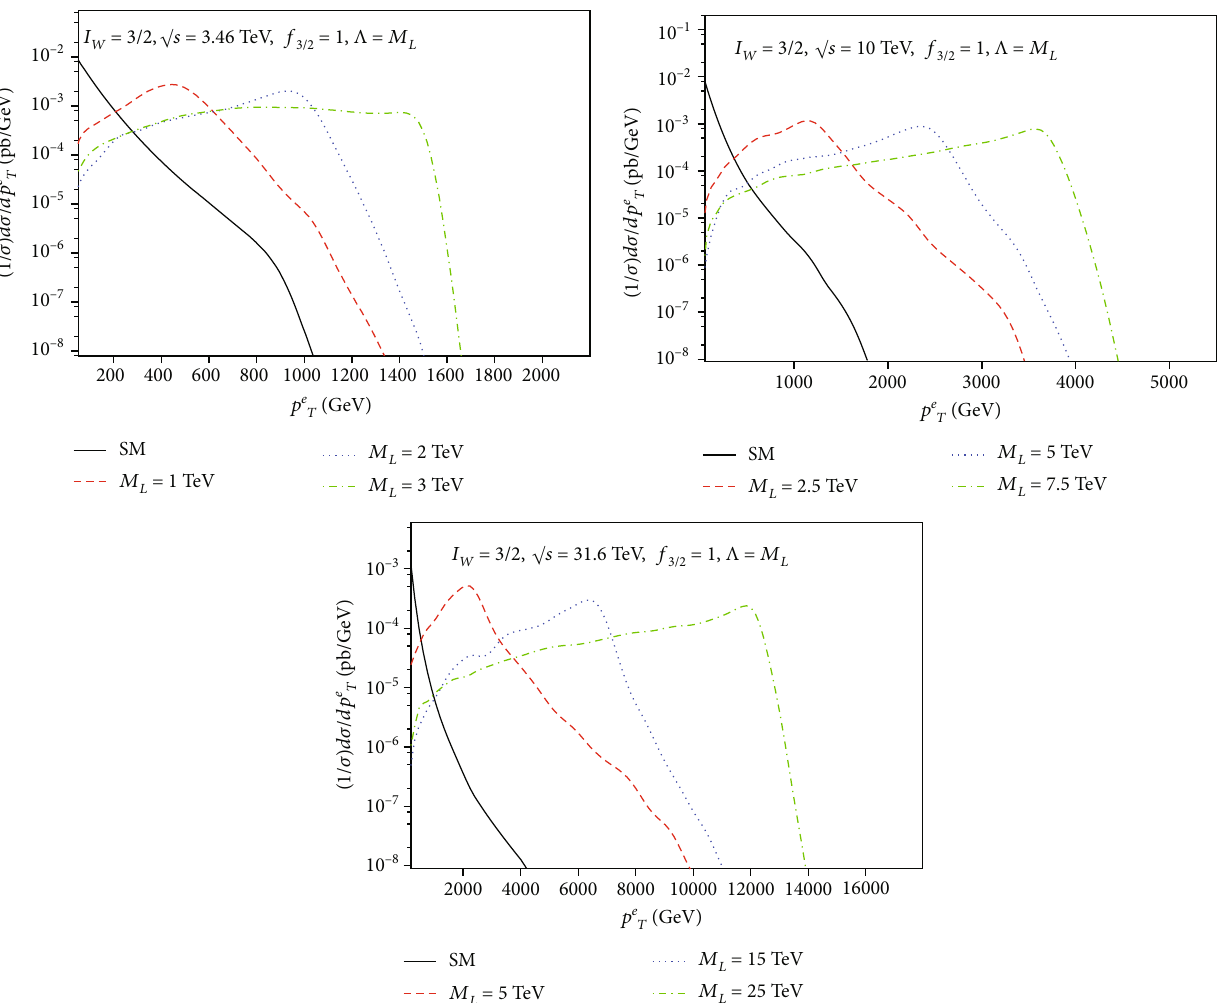
= 1 and Λ = M for various ep 3/2 L